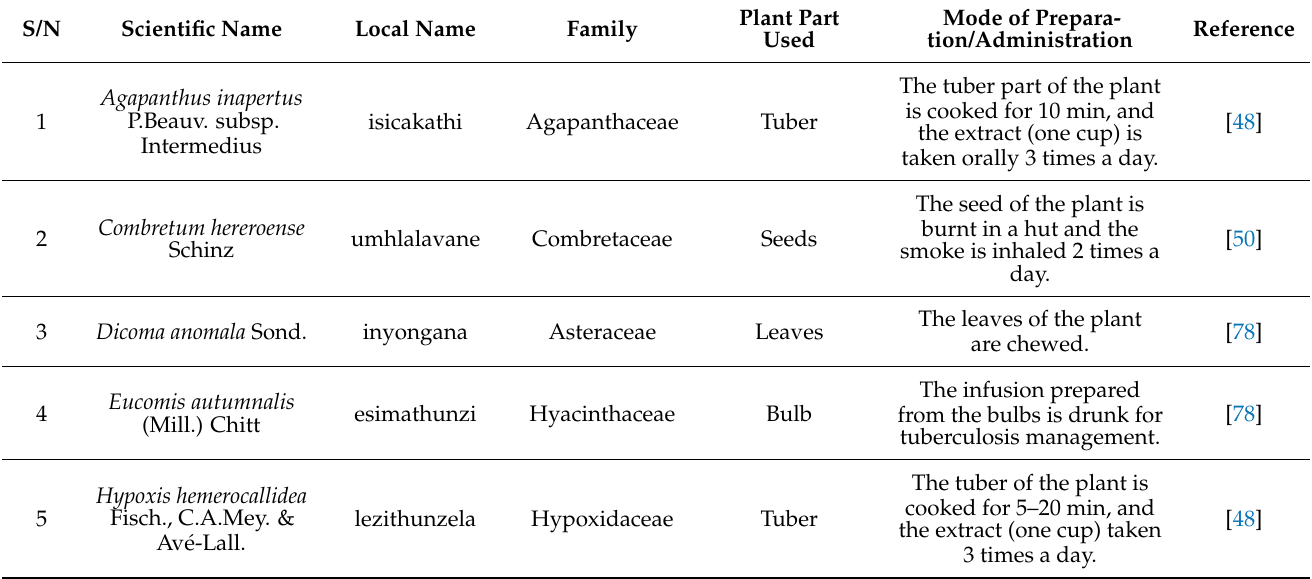
Table 2. Medicinal plants used traditionally to treat tuberculosis in the Mpumalanga Province of South